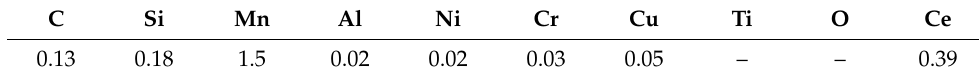
Figure 1. The welding of the specimens: ( a )—welding bead on one side; ( b )—welding bead on both sides. (1, 2, 3, 4, 5—the sequence of the deposition of welding beads). Table 1. Nominal chemical composition for S355 steel.